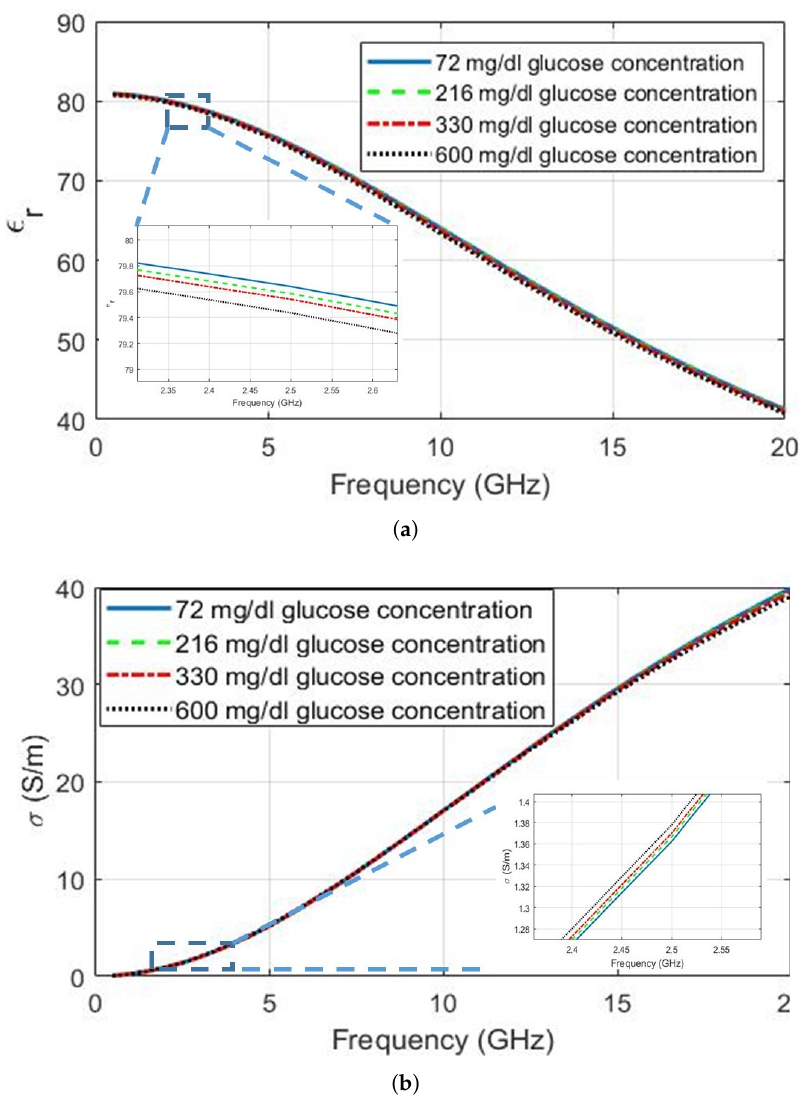
Figure 3. Dielectric properties of water with glucose variations graphed with Debye parameters polynomials given in [33]: ( a ) relative permittivity; ( b )